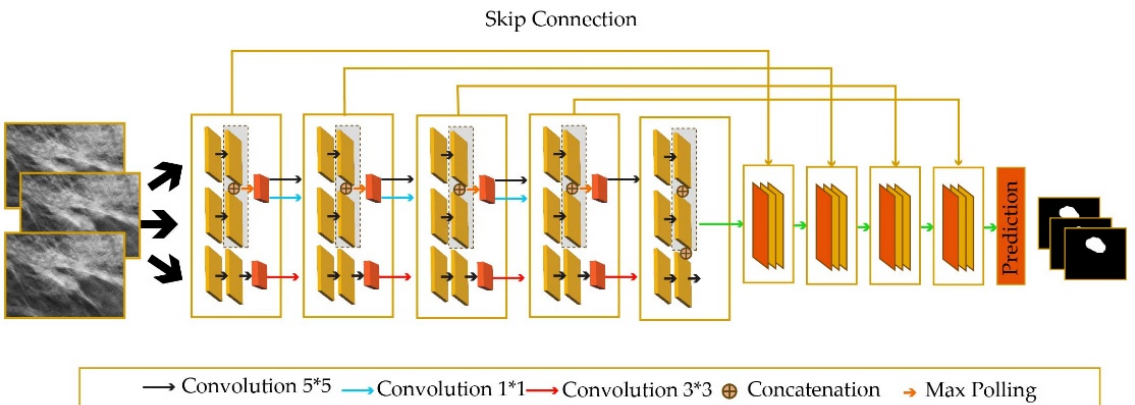
Figure 6. Small Tumor-Aware Network (STAN) to improve the performance of segmenting tumors with different sizes.